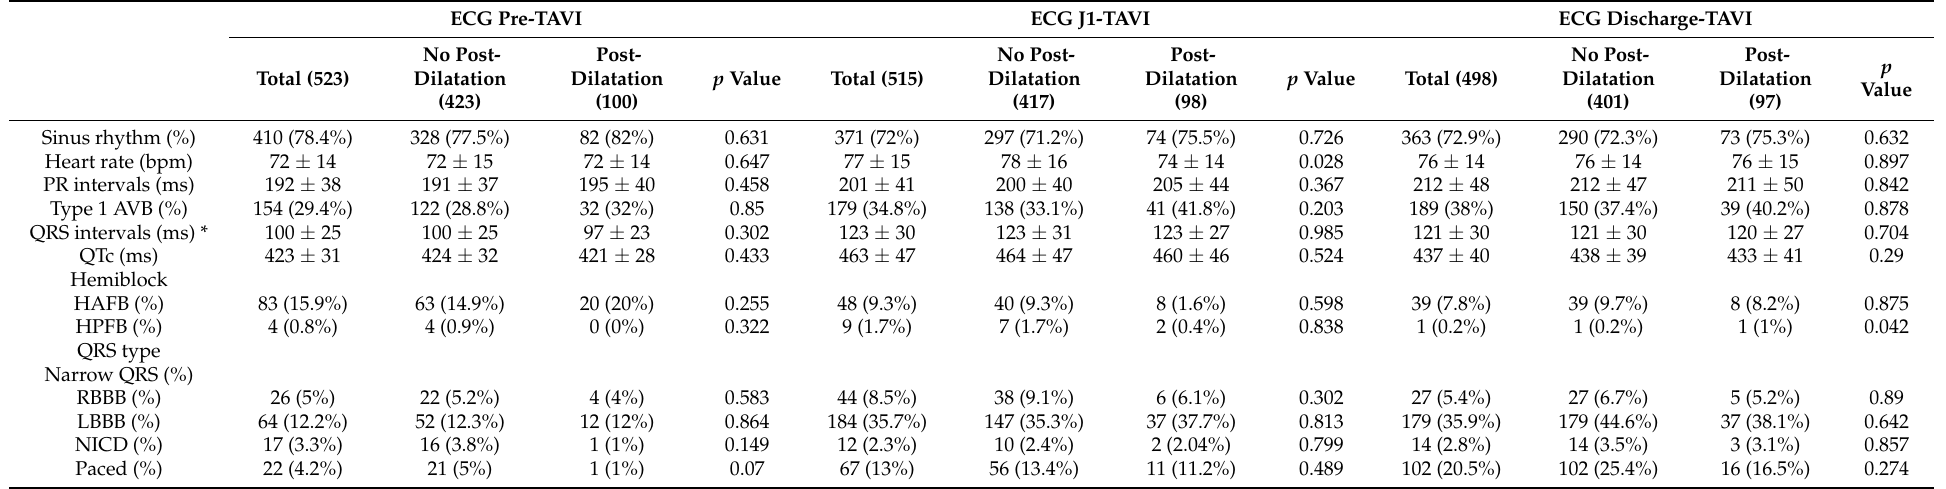
Table 2. ECG characteristics before and after TAVR and at